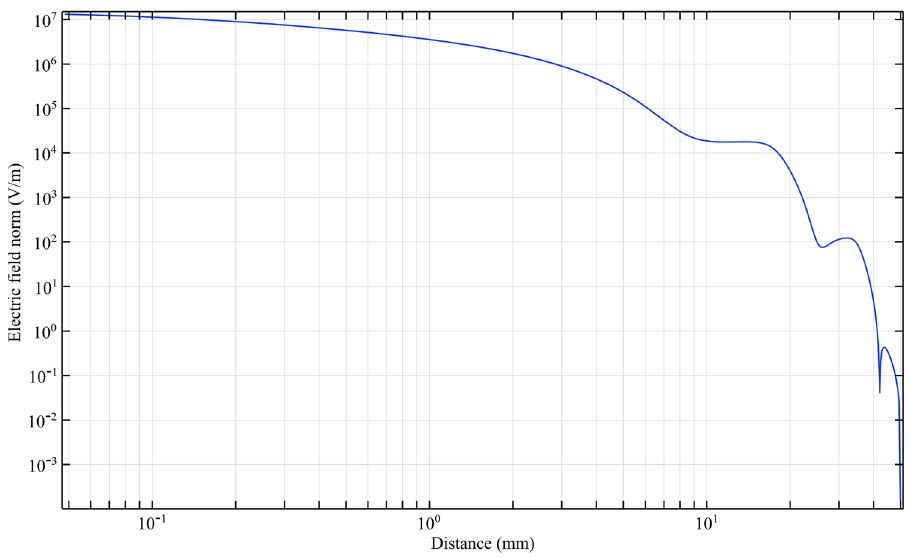
Figure 12. Simulation of electric field from tip electrode to end of plasma jet nozzle based on nozzle Fig. 9c.